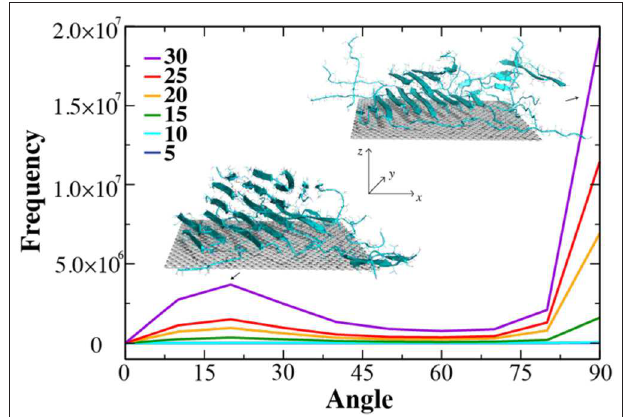
FIGURE 4 | The growth of β -sheets by increasing of number peptides on the surface of graphene nano-sheet. The distribution of angle between graphene surface norm and elongation vectors of neighbor β -sheets were computed from consecutive simulations where the number of NACore peptide were added up to 30 with the increment of